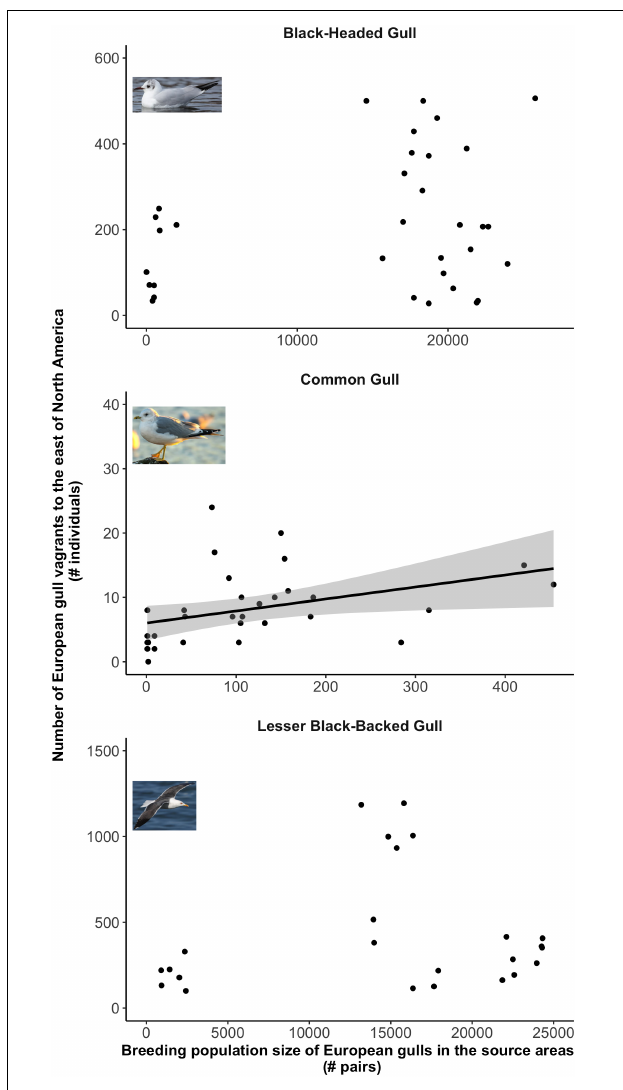
FIGURE 4 | Relationship between the number of European gull vagrants reported in eastern North America in a given year and the size of their source populations in the previous year. Only Common Gull showed a statistically significant relationship between these two variables. Note that both axes have different